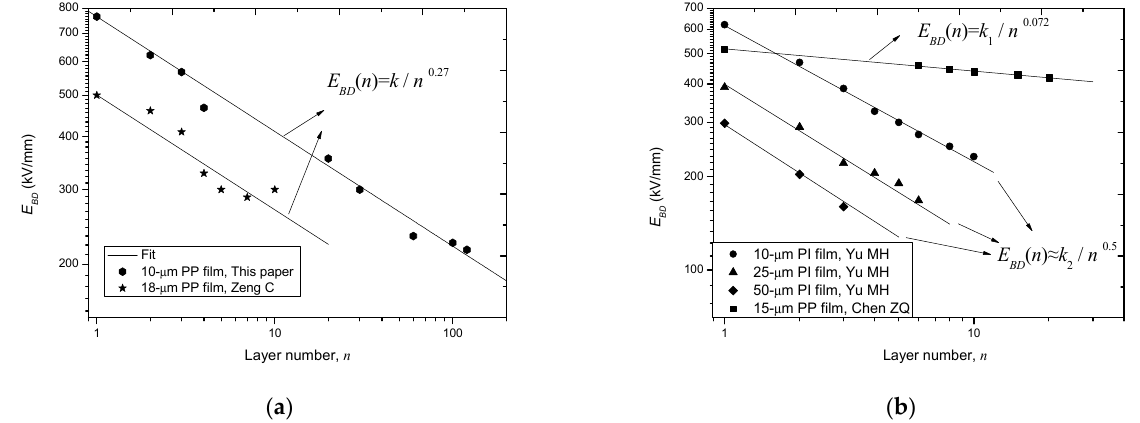
Figure 3. Re-plot and fit different groups of E BD - n data in log-log coordinate systems. ( a ) E BD - n data with moderate tendency; ( b ) E BD - n data with sharp and slow tendencies.